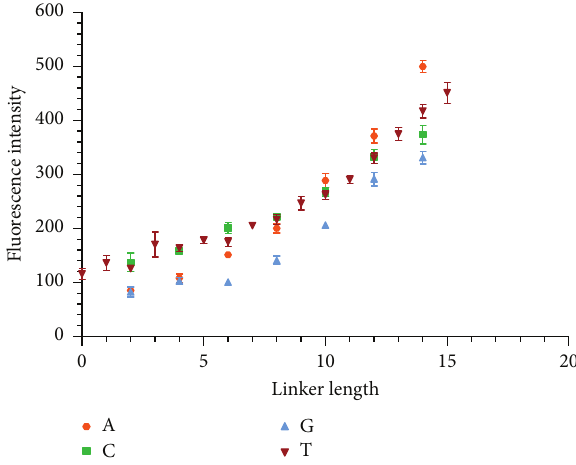
Figure 3: Response of IgE D17-4 aptamer to 100nM Cy3-IgE using different nucleobase linkers in PBSMTB buffer. Error bars represent SEM of raw fluorescence intensity values for six replicates of each